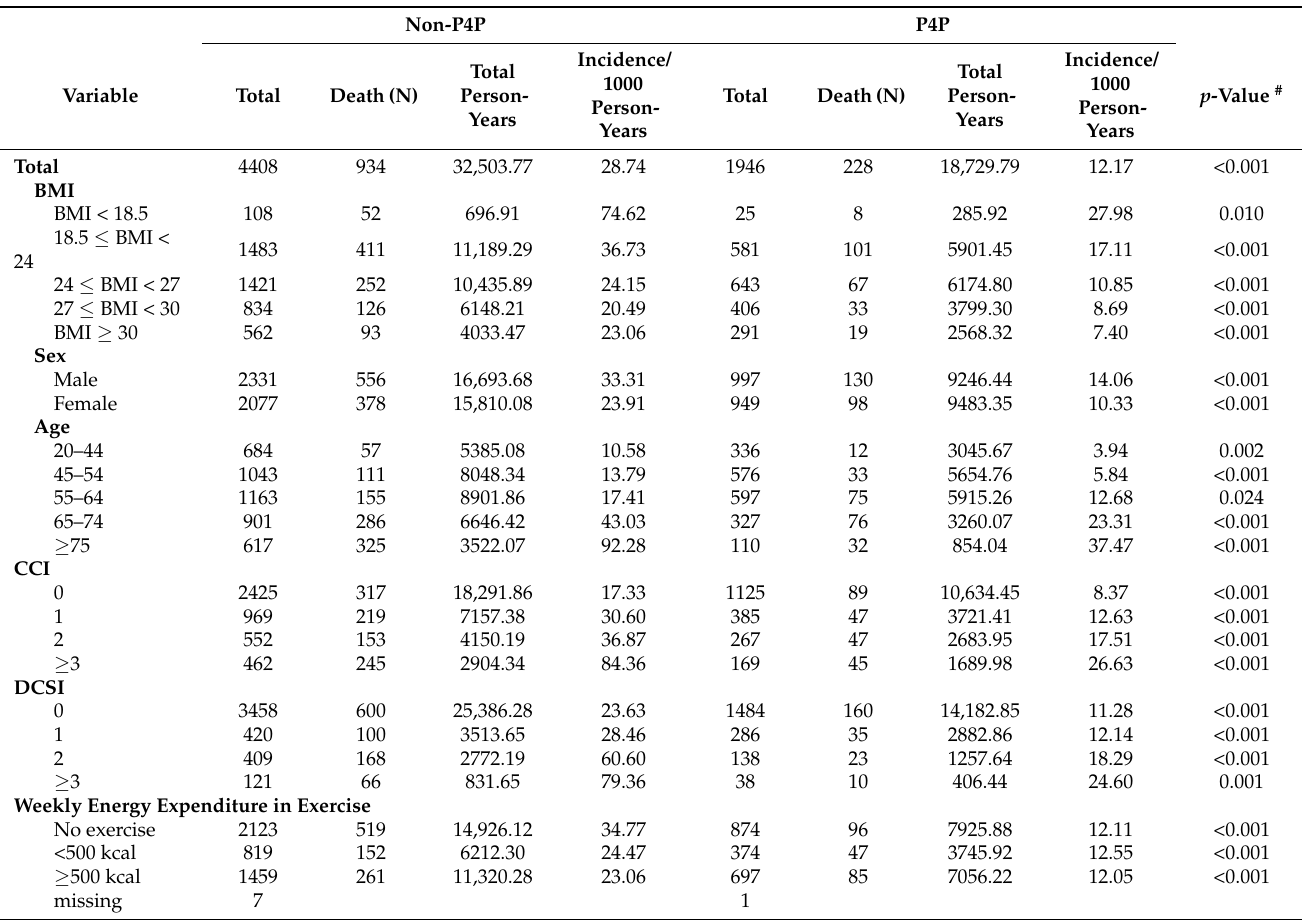
Table 3. Comparison of mortality rate per 1000 person-years in DM patients with different BMIs after participation in P4P program.